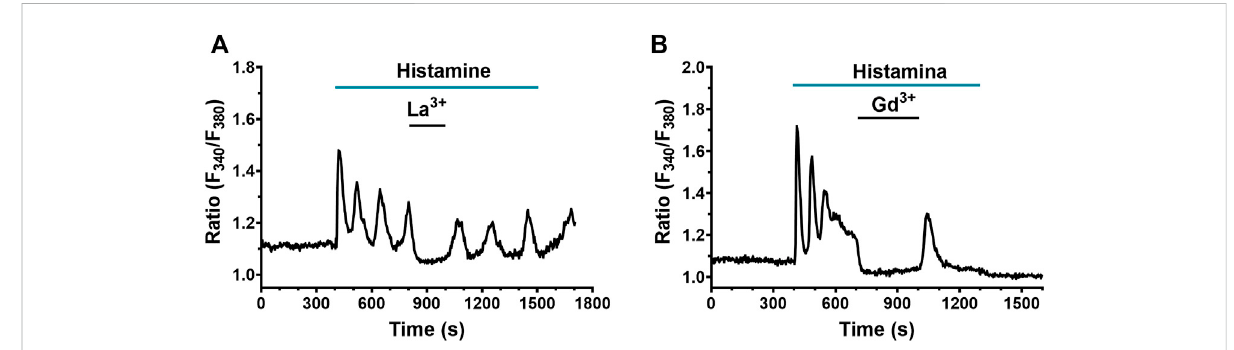
FIGURE 9 Effect of SOCE blockade on histamine-evoked Ca 2+ signals in WI-38 human lung fi broblasts. (A) Typical recording of histamine-evoked Ca 2+ signals and effect of the application of 10 µM La 3+ ( n = 79). (B) Typical recording of histamine-evoked Ca 2+ signals and effect of the application of 10 μ M Gd 3+ ( n =